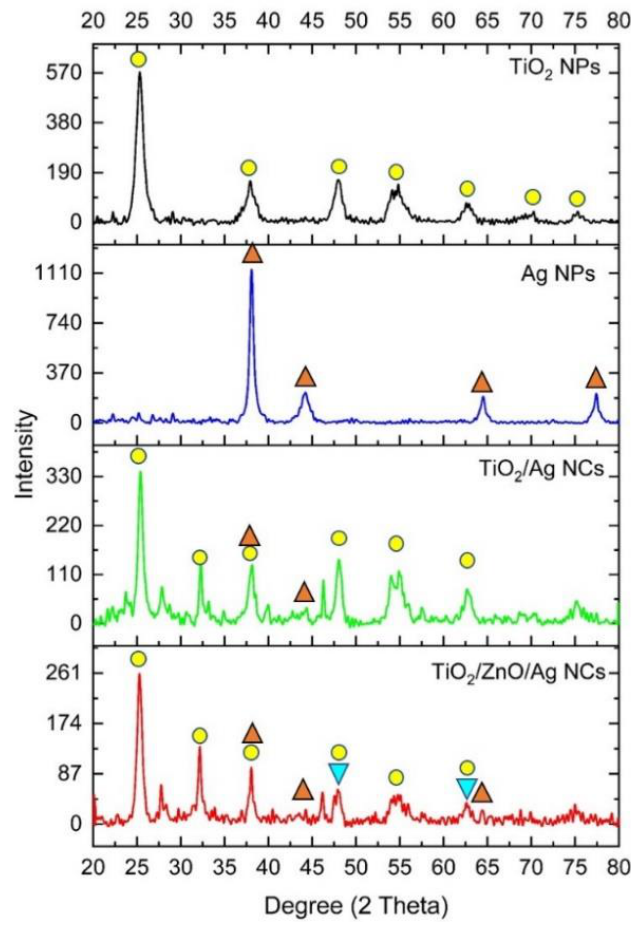
Figure 3. XRD pattern of TiO 2 NPs, AgNPs, TiO 2 /AgNCs and ZnO/TiO 2 /AgNCs.